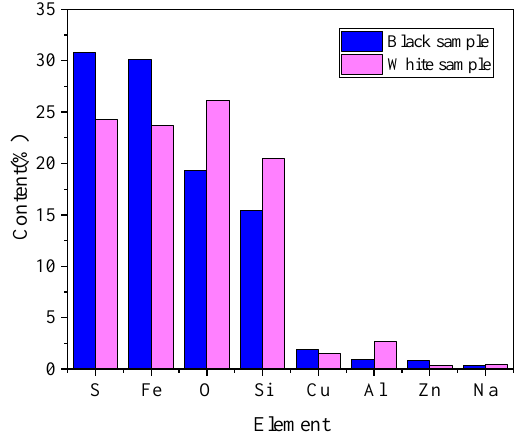
Figure 16. Element content of specimens.